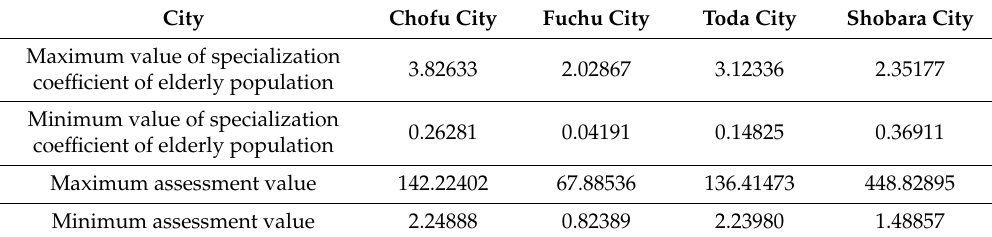
Table 5. Results with the specialization coe ffi cient of elderly population as a weighted coe ffi